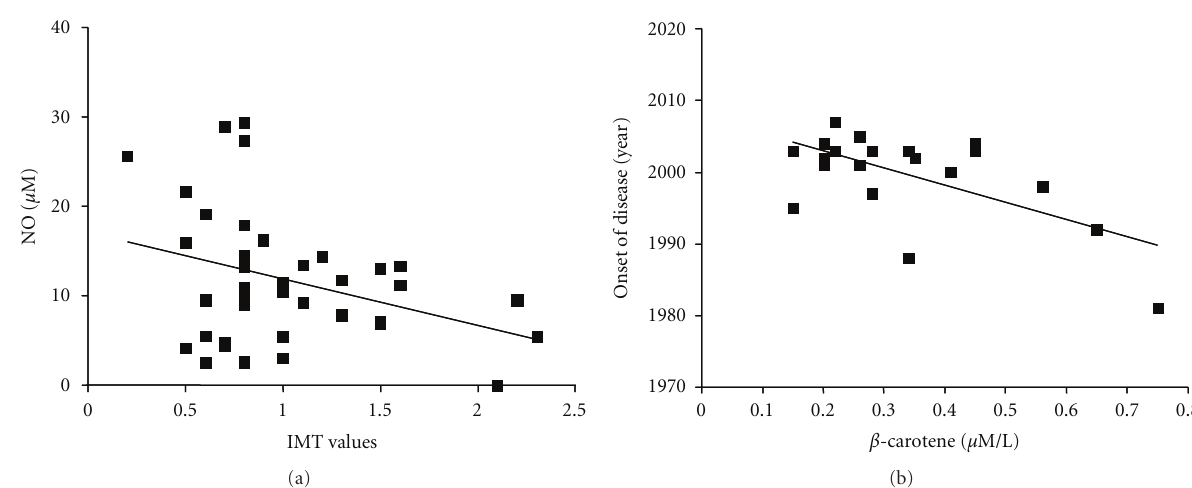
Figure 5: Correlations between clinical and serological variables . (a) Negative correlation between nitric oxide (NO) levels and intima-media thickness (IMT) values in rheumatoid arthritis (RA) and psoriatic arthritis (PsA) patients. R = − 0 . 3, P = 0 . 033. (b) Negative correlation between β -carotene levels and the onset of the disease (evaluated in terms of year in which the disease was diagnosed) in RA patients. R = − 0 . 62, P = 0 . 028.